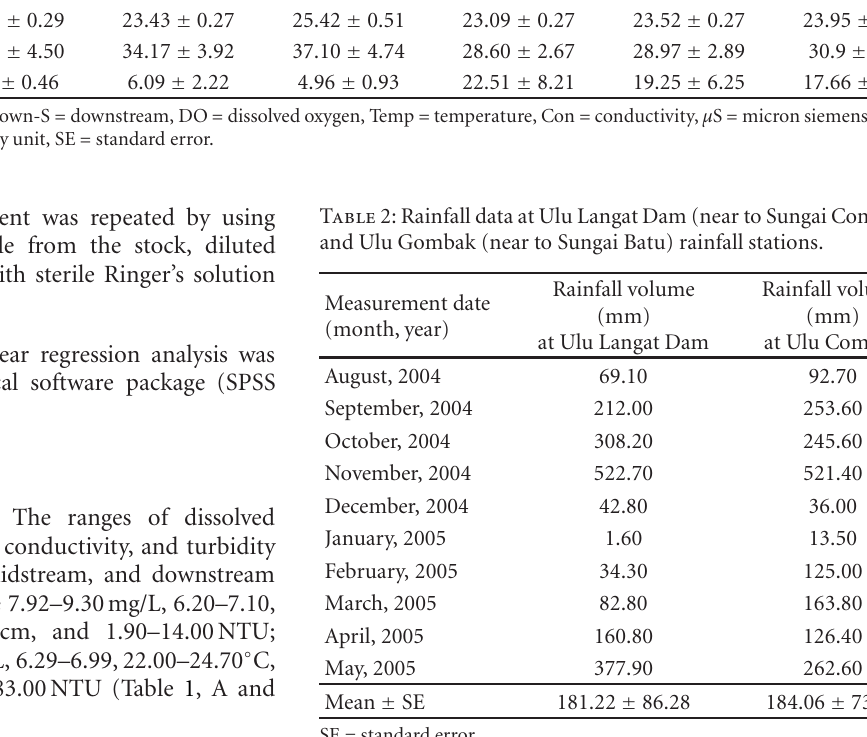
Table 1: Mean physical parameters of the water at up-, mid-, and downstream station of Sungai Congkak and Sungai Batu. Sungai Congkak Sungai Batu Mean ± SD of parameter Up-S Mid-S Down-S Up-S Mid-S Down-S DO (mg/L)